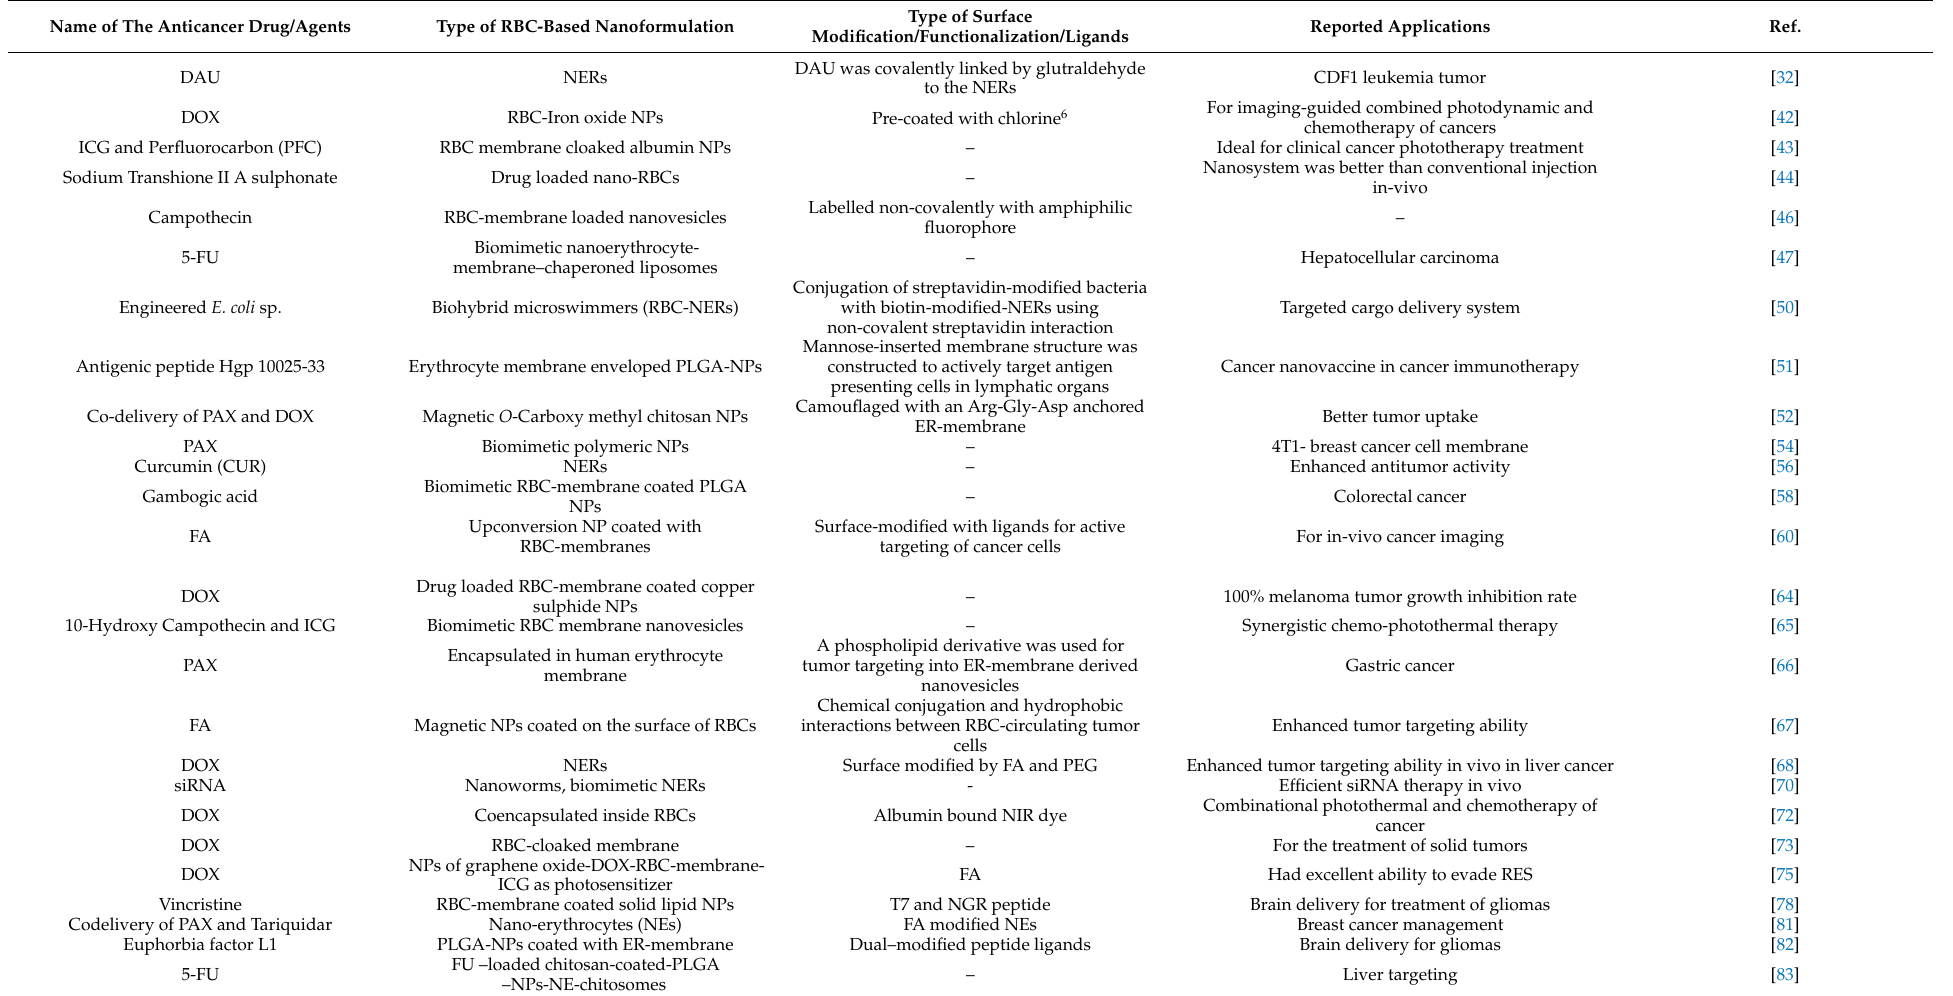
Table 1. Anticancer nanoformulations of nanoerythrocytes (NER), their surface modification and specific tumor targeting